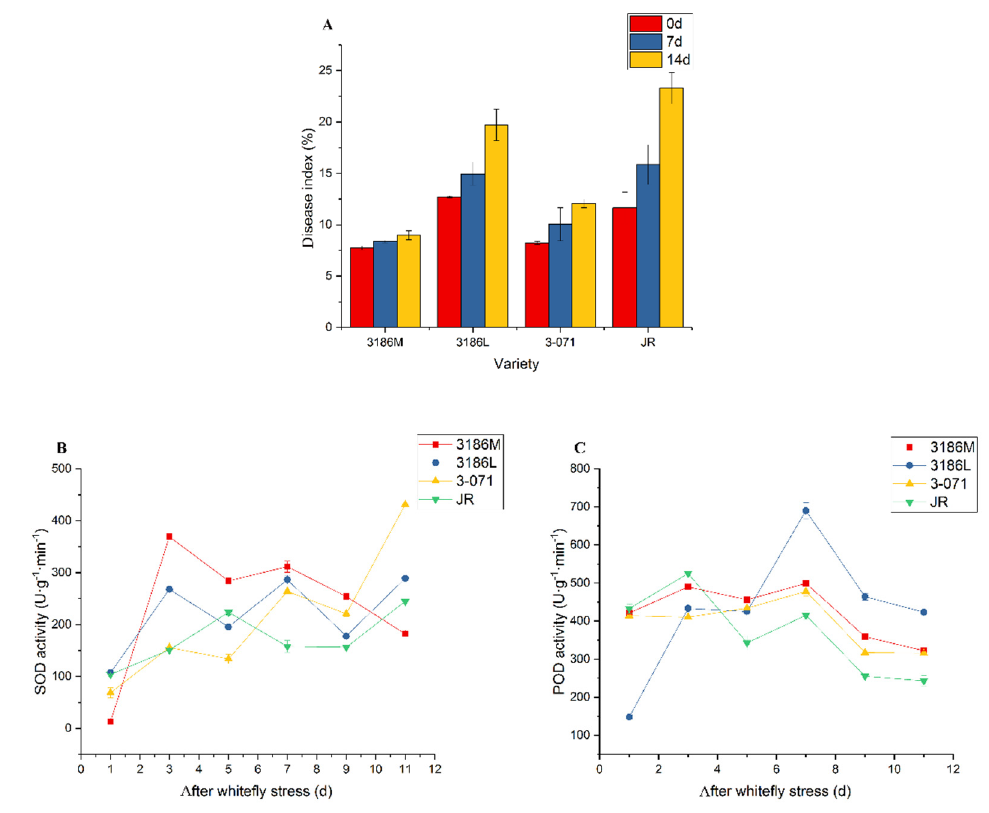
Figure 8. ( A ) Insect density on tomatoes with di ff erent trichome types; the density was measured at various times after treatment with whiteflies. ( B ) Changes in the SOD activity in the four tomato accessions at various times after treatment with whiteflies. ( C ) Changes in the POD activity in the four tomato accessions at various times after treatment with whiteflies. The content of SOD and POD were measured as previously reported [24]. The data represent the means of three replicates ± SD. All experiments were repeated three times with similar results.